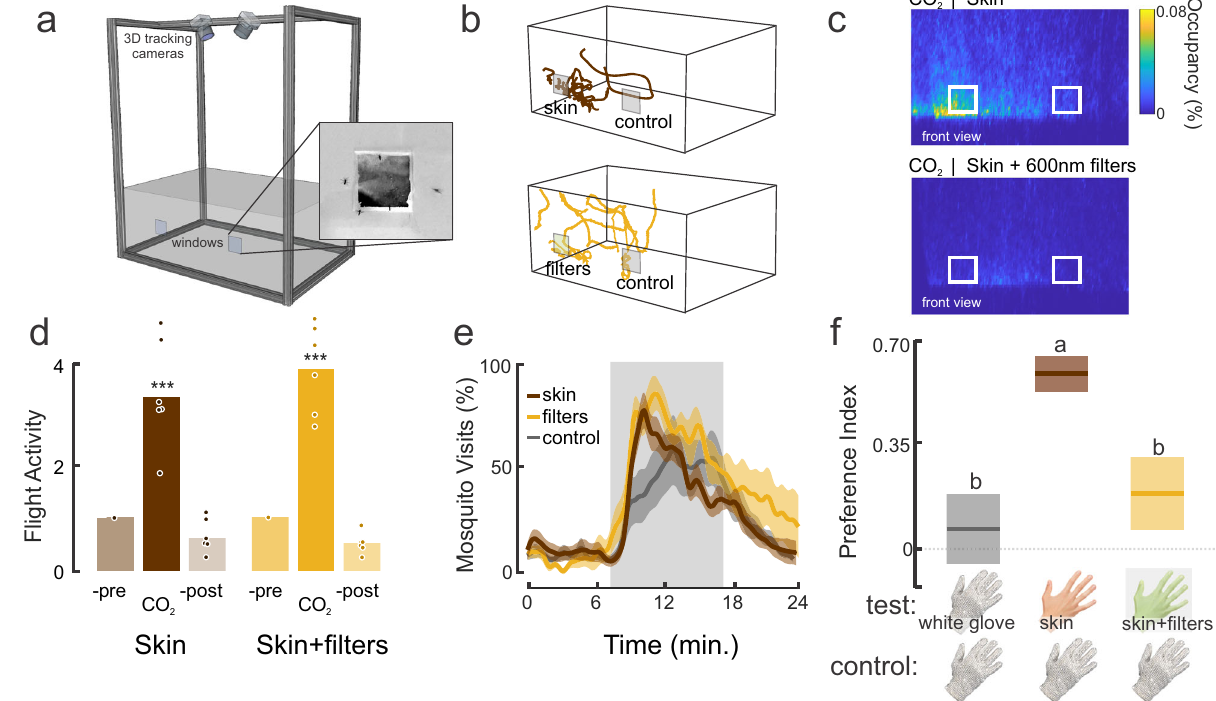
Fig. 3 The importance of long wavelengths in attraction to human skin. a Cage assay with real-time tracking system, odor, and visual stimulation through two windows on the front of the cage. b Example of individual trajectories (top: skin and control (white glove), bottom: skin + fi lters (550 – 700 nm), and control). c Occupancy maps showing the distribution of female mosquitoes during CO 2 stimulation while in presence of the skin and control (top), and the skin + fi lters (550 – 700 nm) and control (bottom). d Relative fl ight activity between the different phases of the experiments (pre-, CO 2, and post-CO 2 ) for the skin and skin + fi lters treatments ( n = 6 trials/treatment). There was no signi fi cant difference in the relative activity during the CO 2 phase between the skin and skin + 600-nm fi lter treatments (Kruskal – Wallis test, df = 1, Chi-sq = 0.004, P = 0.96). e The percentage of mosquitoes visiting the windows over the duration of the experiment. Few mosquitoes investigated the windows before the CO 2 exposure. However, exposure to CO 2 signi fi cantly increased the numbers of mosquitoes visiting the windows relative to the pre-CO 2 period (Kruskal – Wallis test with multiple comparisons: df = 5, Chi-sq. = 277.85, P < 0.0001), although during CO 2 there were no signi fi cant differences in the total number of mosquitoes investigating the windows between treatment groups (Kruskal – Wallis test with multiple comparisons: P > 0.57). Lines are the means and shaded areas the ±sem. f Mean preference index for the different treatment groups (white glove vs. white glove, skin vs. white glove, and skin + fi lter (550 – 700 nm) vs. white globe). Boxplots area the mean (line) with 95% con fi dence interval (shaded area). Different letters denote statistically signi fi cant differences between groups (Kruskal – Wallis test with multiple comparisons, P < 0.01). ( n = 13,597 for the skin treatment group; n = 9502 for the for the skin + fi lters treatment group; and n = 9368 for the control